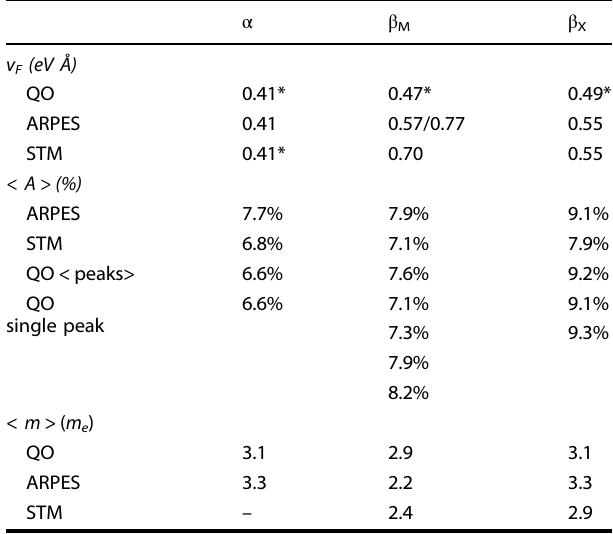
Table 1. Summary of band structure parameters from different